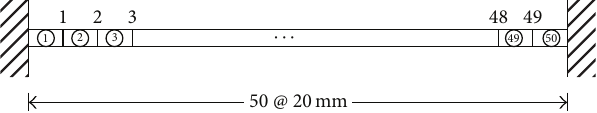
Figure 1: A fixed-end beam structure model.